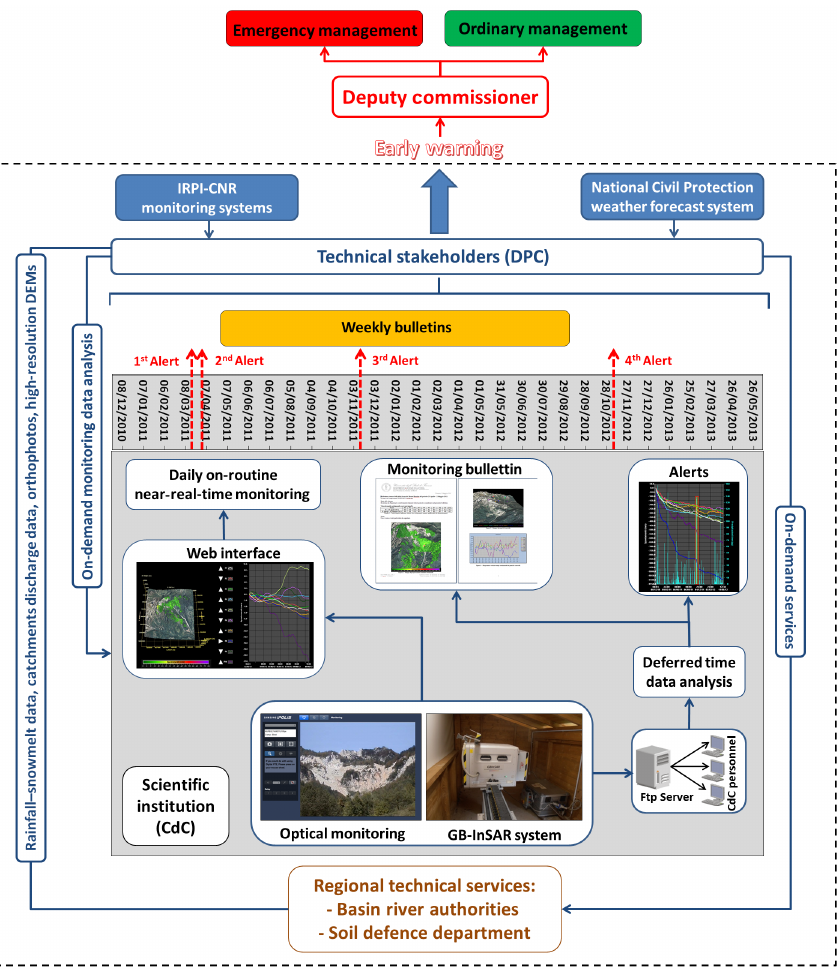
Figure 6. Timeline rationale of the Rotolon monitoring system and emergency management procedures. The black dashed box includes the early warning